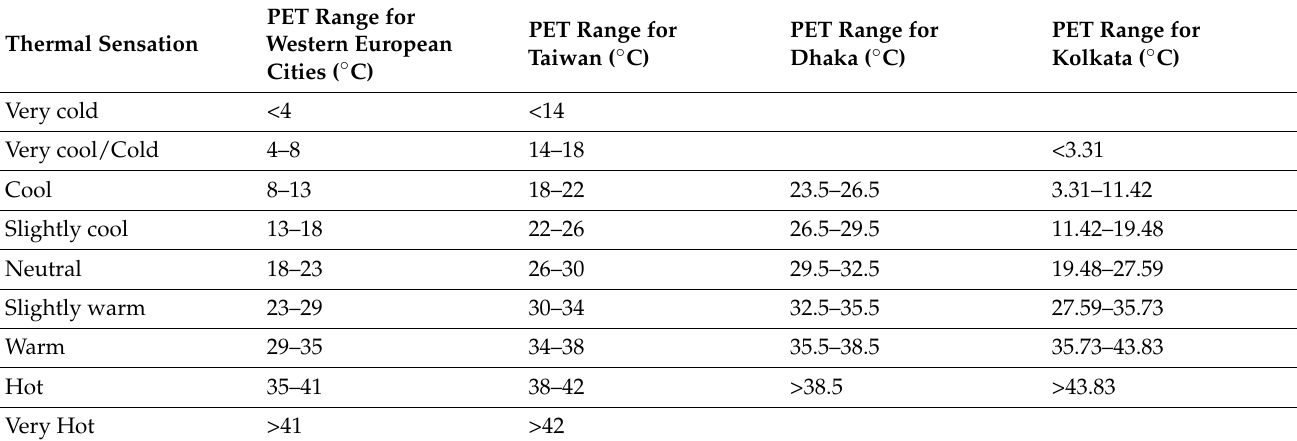
Table 2. Categorized PET equivalent temperatures as a function of the thermal sensation for Kolkata [52], Taiwan [71], Western European cities [72–74], and Dhaka [75]. This present study used the PET classification of Kolkata